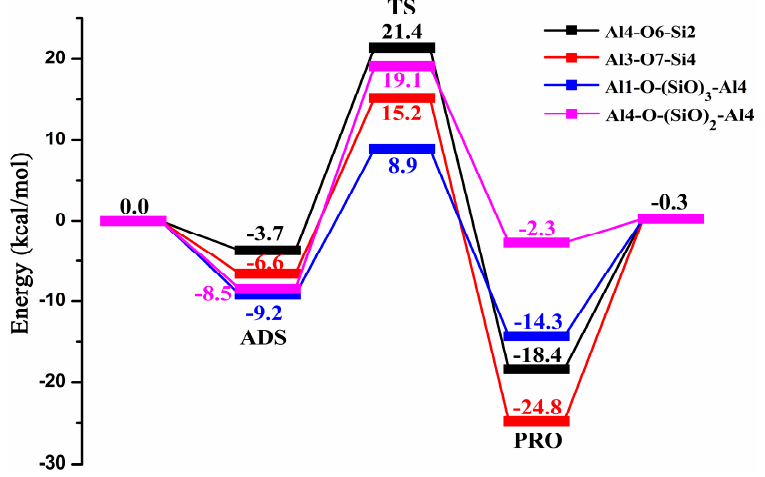
Figure 6. The energy profiles of the isomerization of 1 ‐ butene to 2 ‐ butene over the different Brönsted acid sites.